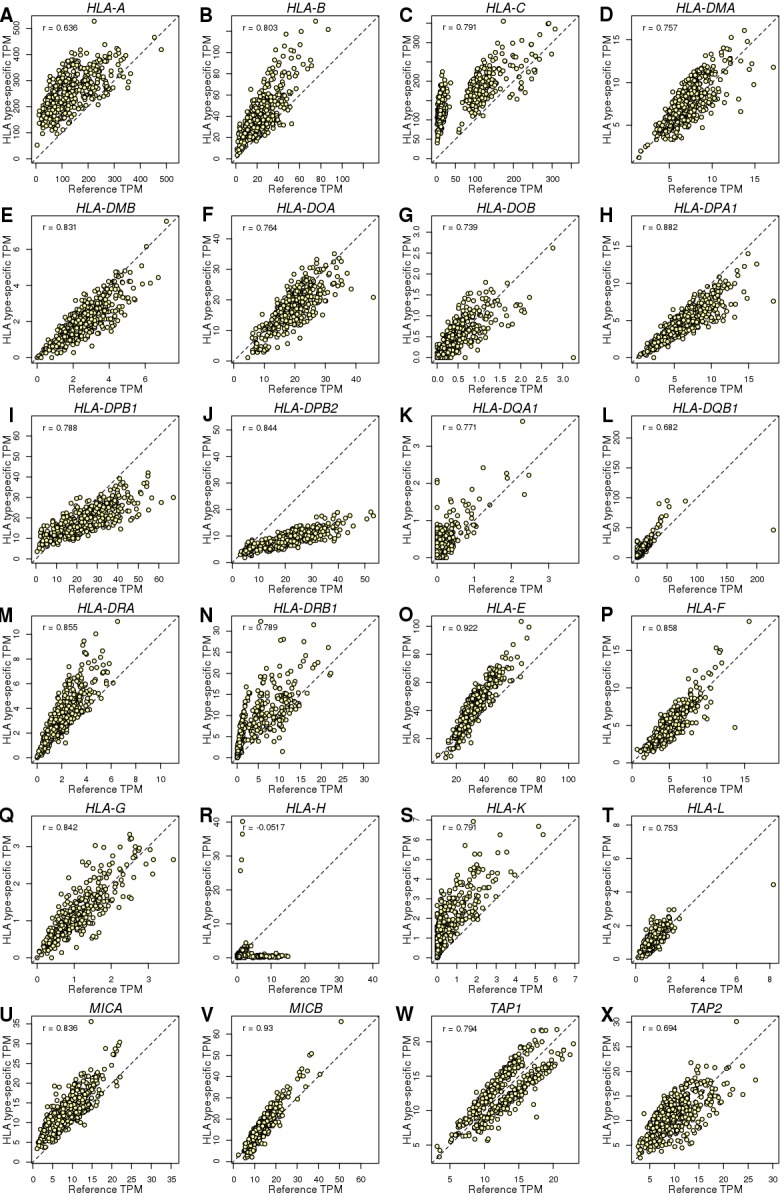
HLA genes – Reference versus HLA type-specific expression.Scatterplots showing the differences between TPM calculated by aligning RNA-seq reads to reference cDNA sequences (X axis) and HLA type-specific cDNA sequences (Y axis). To determine whether aligning RNA-seq data to HLA type-specific cDNA sequences improved predicted gene expression levels, we tested the differences between reference and HLA type-specific TPM and found that their correlation ranged between −0.052 (HLA-H; panel R) and 0.93 (MICB; panel V). However, only HLA-H which had very low expression levels (median HLA type-specific TPM = 1.1) had correlation < 0.6. These data suggest that a substantial portion of the gene expression heterogeneity captured when estimating expression levels from RNA-seq reads aligned to HLA type-specific cDNA sequences is not detected when RNA-seq reads are aligned to reference cDNA sequences. We calculated this fraction as 1 – R2 and found that it accounts for 0.13 (MICB) to 0.59 (HLA-A).